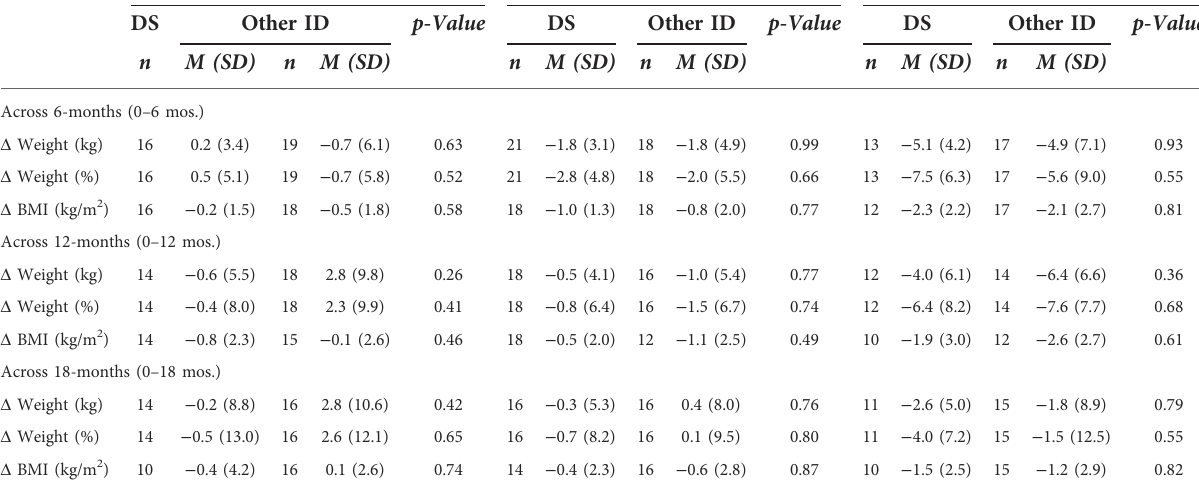
TABLE 2 Change in weight and BMI across 6, 12 and 18 months in adolescents down syndrome (DS) and other intellectual disability (ID) by intervention